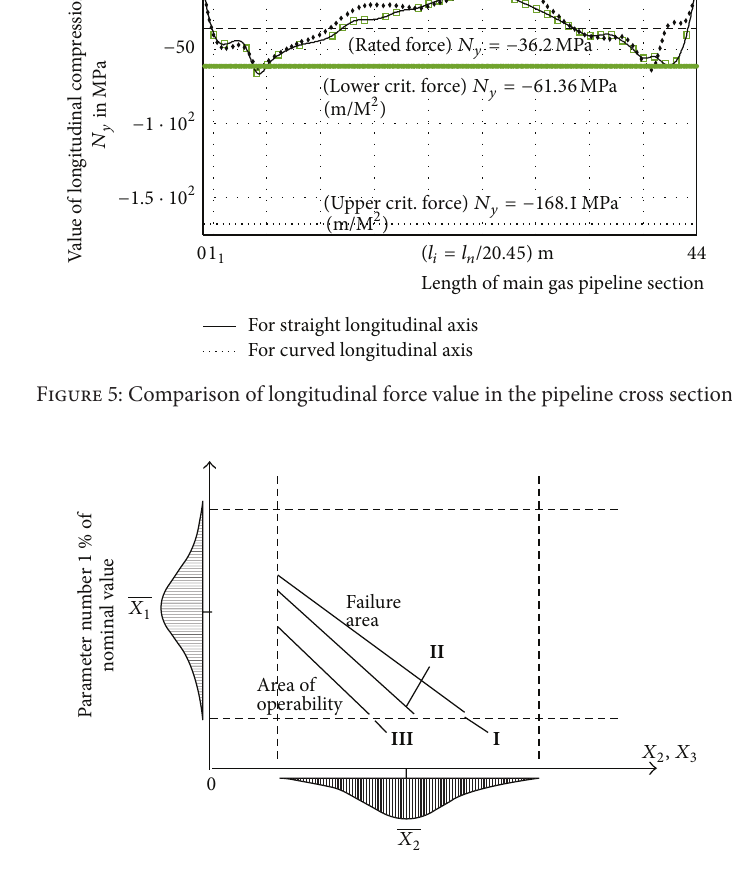
Figure 6: Compound diagram of failure-free operation